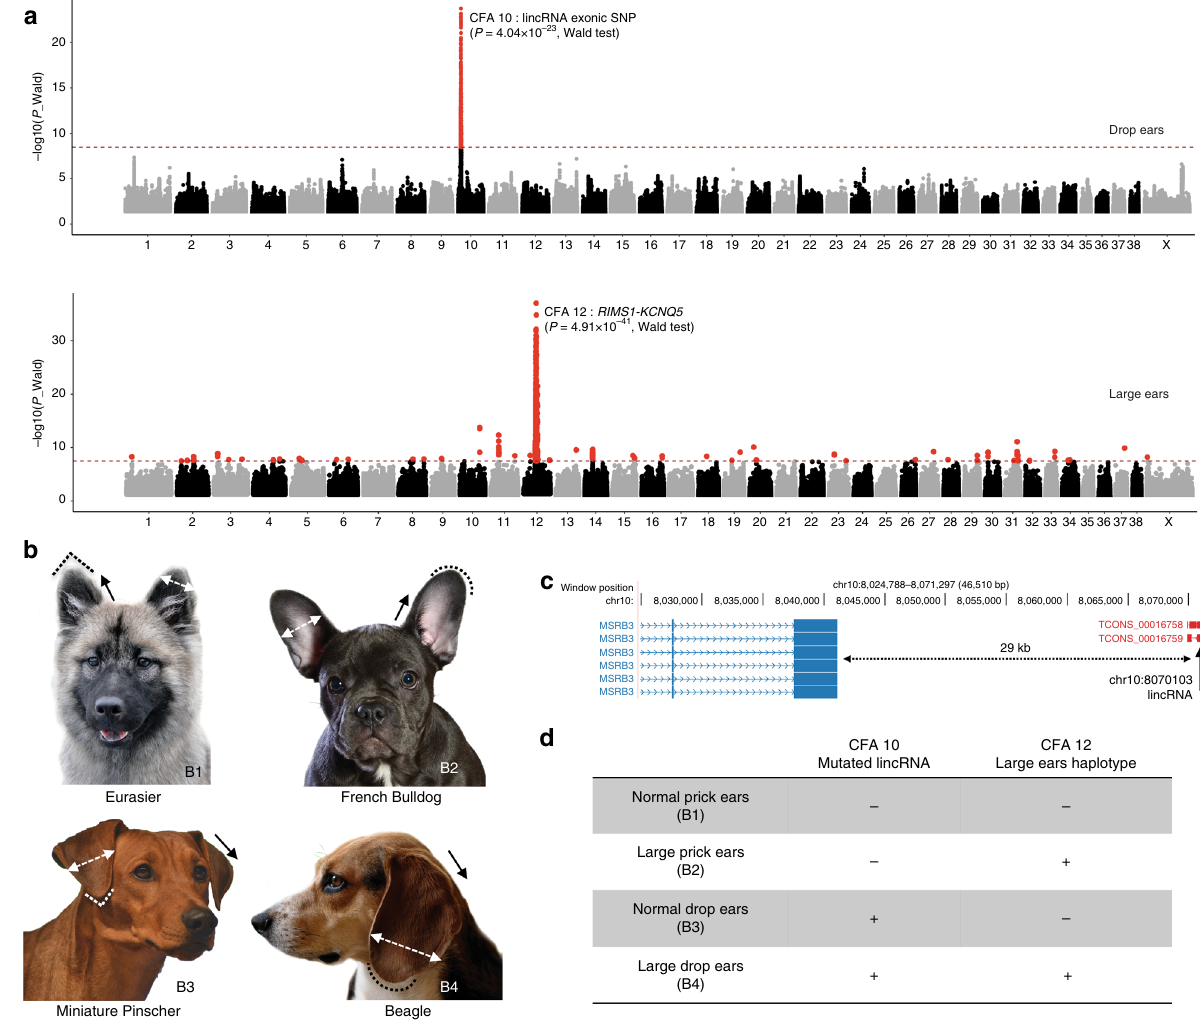
Fig. 5 Ear morphology in dogs. a Manhattan plots showing one signi fi cant signal on the CFA10 for the drops ears phenotype and another one on chromosome 12 for the large and round ears. b Characteristic breeds representing four different ear shapes observed in dogs: Normal (1,3), large and round (2,4), prick (1,2) or drop (3,4). c UCSC genome browser showing the position on the canine genome (Canfam3.1) of the mutated lincRNA (in red) associated with the drop ears. d Combination of alleles at both loci create four phenotypes. Plus ( + ) and minus signs ( − ) indicate the presence or absence of variant (non-ancestral)